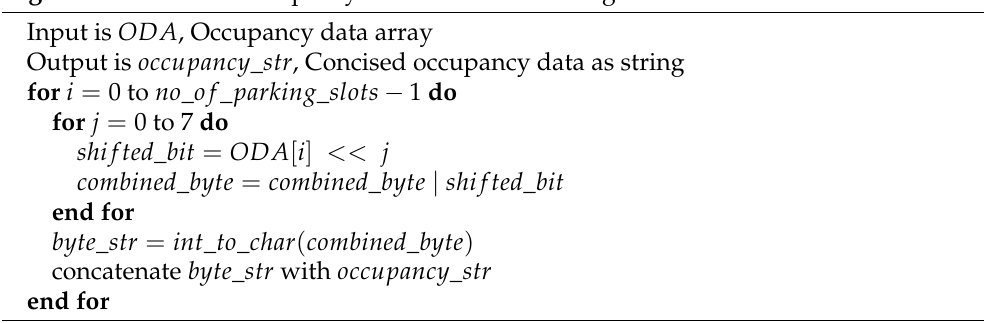
Algorithm 1 Convert occupancy data to a concise string.